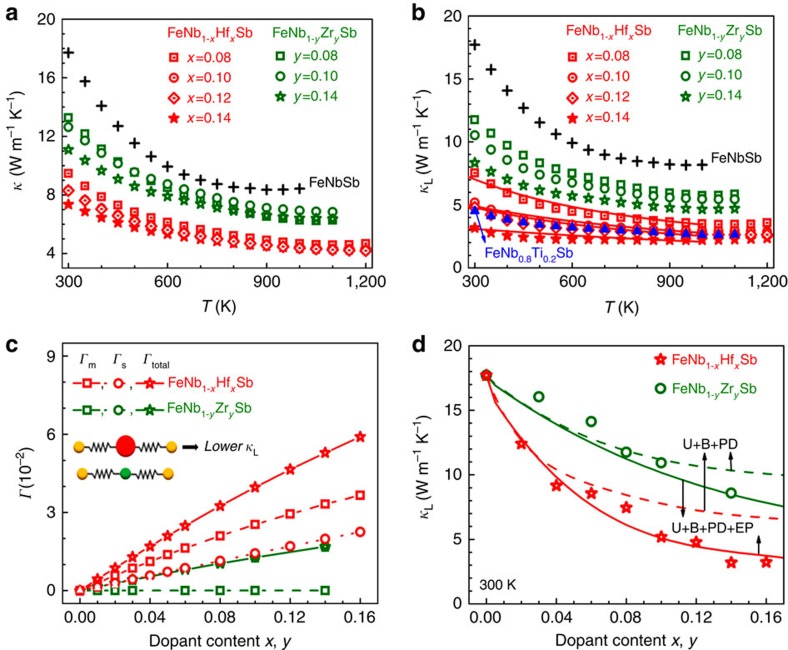
Thermal conductivity for FeNb1−xHfxSb and FeNb1−yZrySb samples.(a) Total thermal conductivity κ. (b) Lattice thermal conductivity κL. The solid curves in b are calculated using the Callaway model3637. For comparison, κL of Ti-doped FeNbSb is also shown19. (c) The calculated disorder parameter Γ for the samples, where Γm (square) and Γs (circle) are mass and strain field fluctuation disorder parameters, respectively.1434
Γtotal=Γm+Γs. (d) Comparison of experimental and calculated κL for the samples at 300 K. The dash and solid curves are calculated without and with electron-phonon scattering, respectively. U, B, PD and EP denote the phonon-phonon Umklapp process, boundary, point-defect and electron-phonon scattering, respectively.